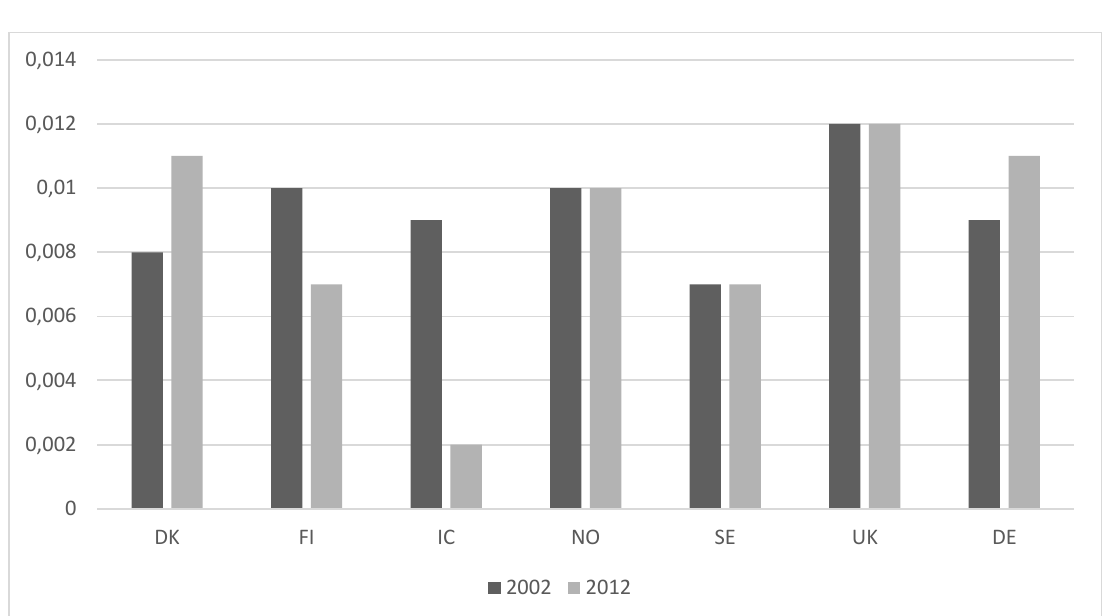
Figure 7: Income-related inequality in self-assessed health as measured by the concentration index (C), Nordic countries, UK and Germany, 2002 and